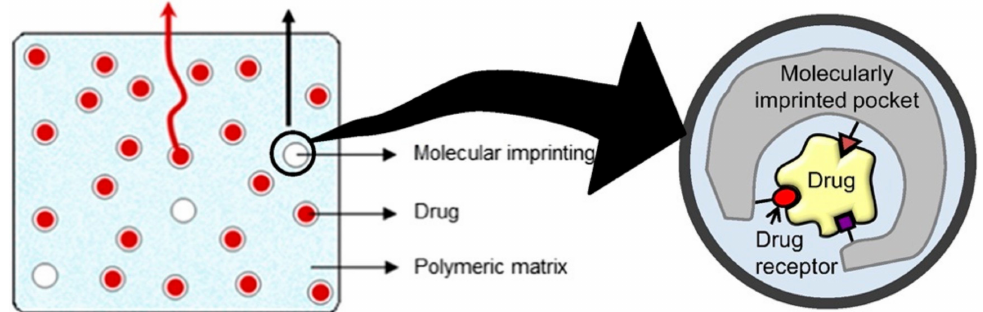
Figure 4. Drug release by molecularly imprinted CL. Reproduced with permission from [53], @Copy- right 2015,